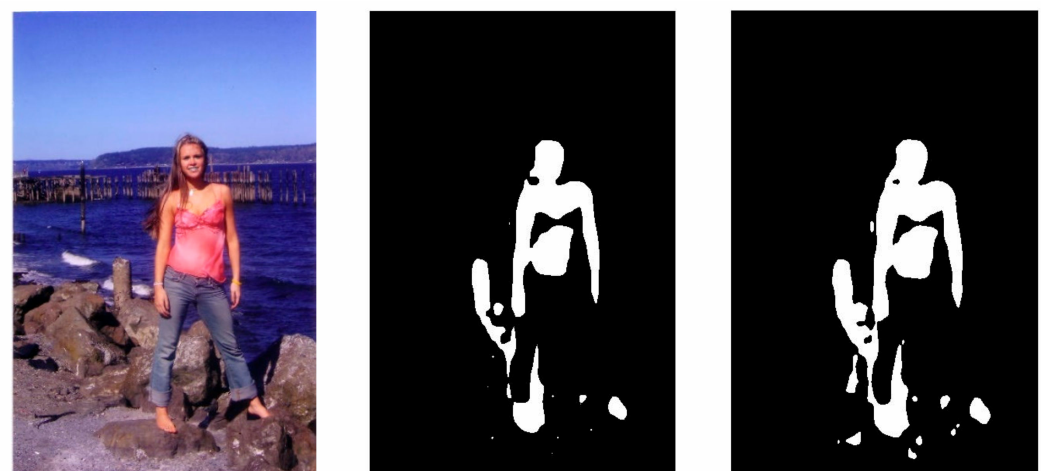
Figure 2. RGB image ( left ), skin mask via FusAct3 + MorphHom ( middle ), and skin mask via FusAct3 ( right ). Sample images in column 1 were taken from the publicly available ECU dataset located at https://documents.uow.edu.au/~phung/download.html, (accessed on 31 May 2021).